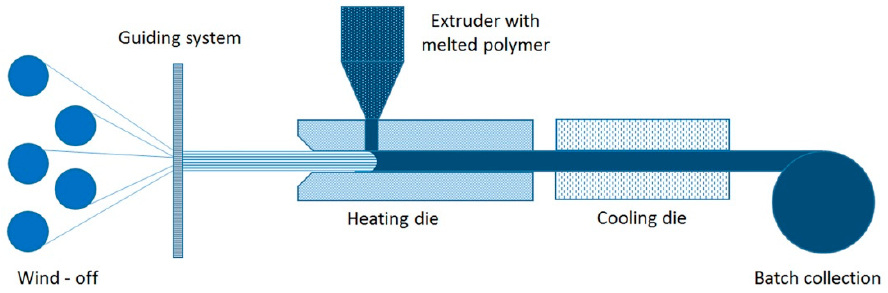
Figure 7. Schematic illustration of a preconsolidated tape (PCT) production